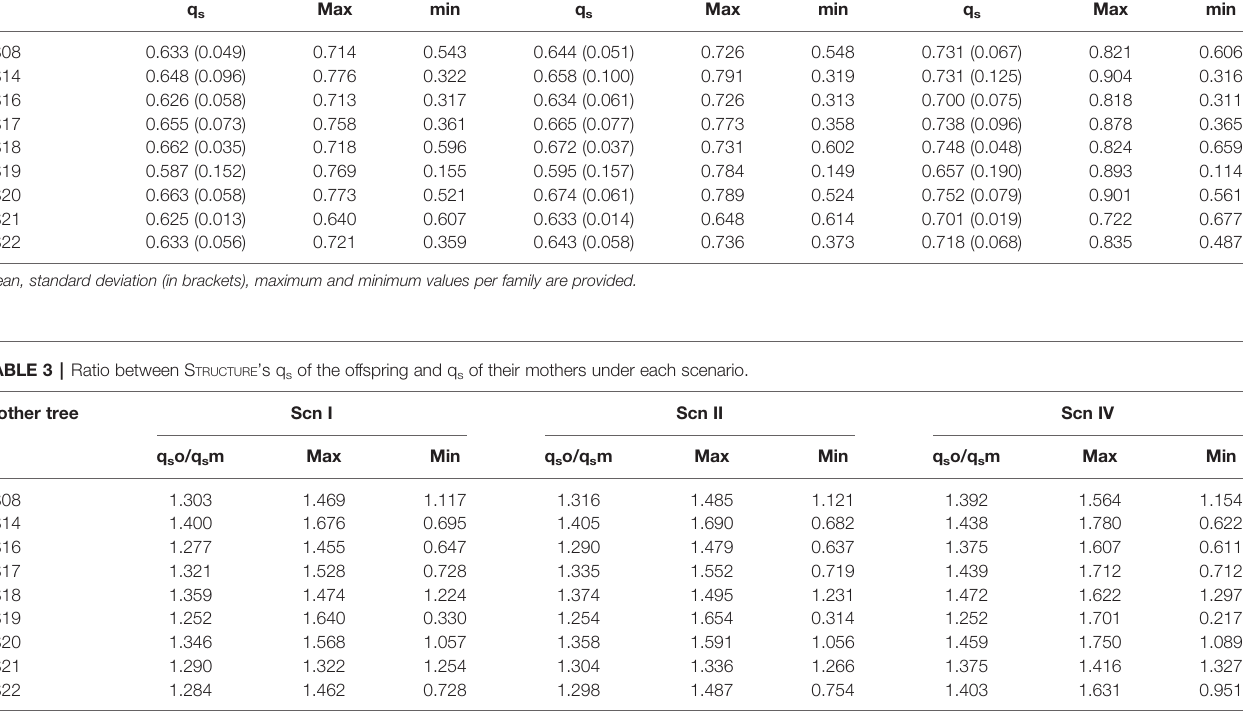
TABLE 2 | S TRUCTURE ’ s q s and I NTROGRESS hybrid index estimates for the progenies of the open-pollinated hybrid families under each scenario. Mother tree Scn I Scn II Scn IV